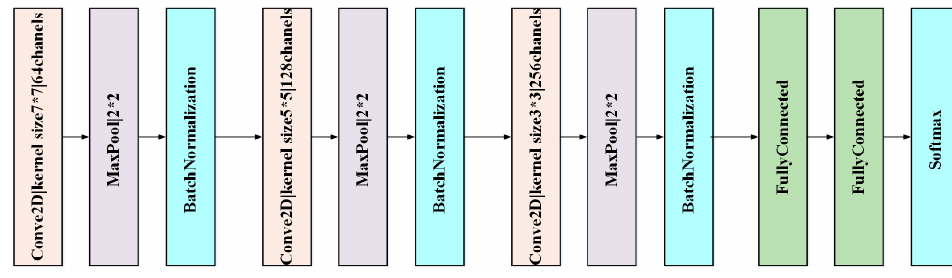
Figure 9. Framework of 2D-CNN.